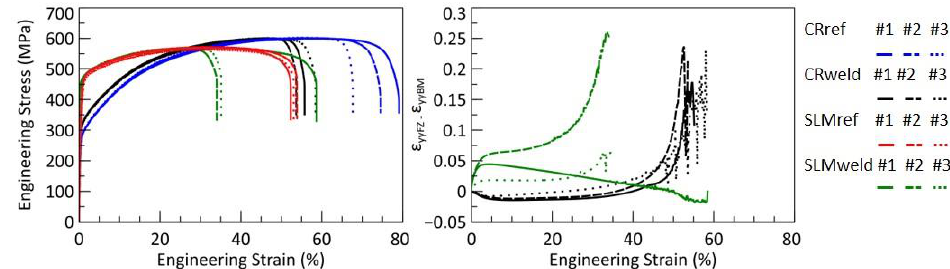
Figure 7. Stress–strain tensile curves of reference and welded samples. Reference samples corre- sponds to non-welded samples. (Right) Evolution of axial strain difference between Fusion Zone (FZ) and Base Metal (BM) with the global strain.